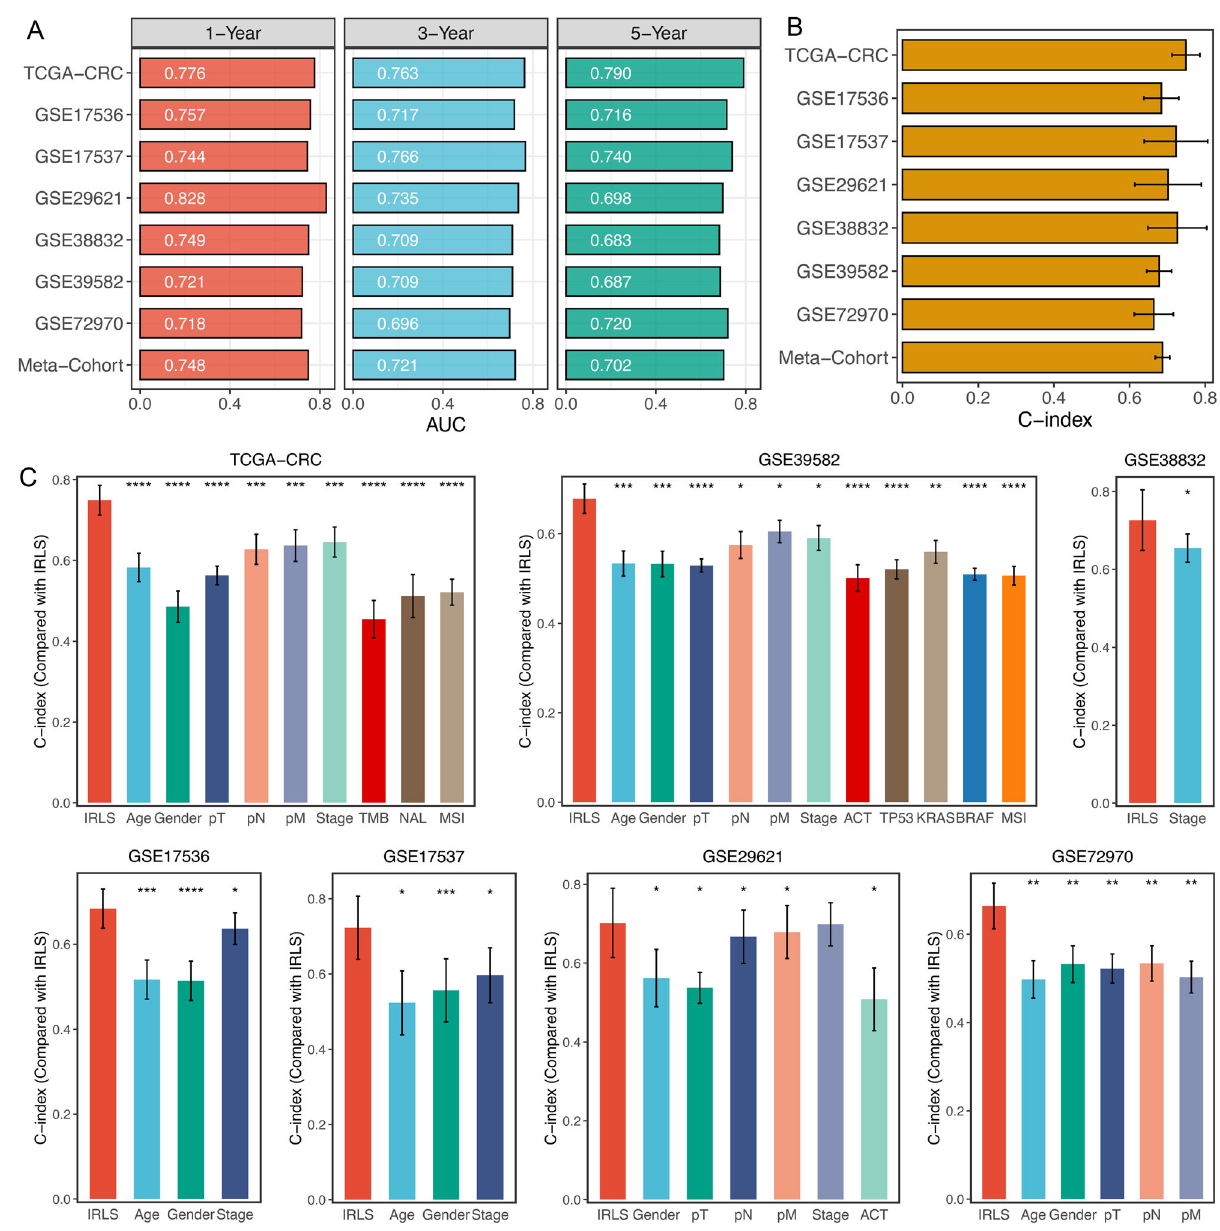
Fig. 3 Evaluation of the IRLS model. A Time-dependent ROC analysis for predicting OS at 1, 3, and 5 years. B C-index of IRLS across all datasets. C The performance of IRLS was compared with other clinical and molecular variables in predicting prognosis. Statistic tests: two-sided z-score test. Data in ( B , C ) are presented as mean ± 95% con fi dence interval [CI]. * P < 0.05; ** P < 0.01; *** P < 0.001; **** P <